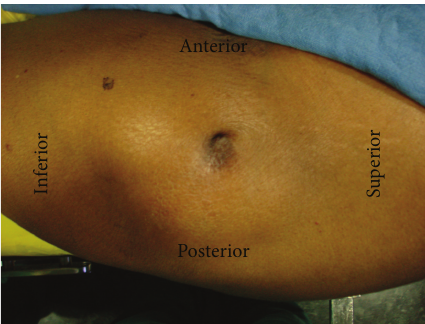
Figure 1: Clinical photograph of the lateral aspect of the left hip region showing a well-defined swelling overlying the left greater trochanter with an adherent dimple scar over it.